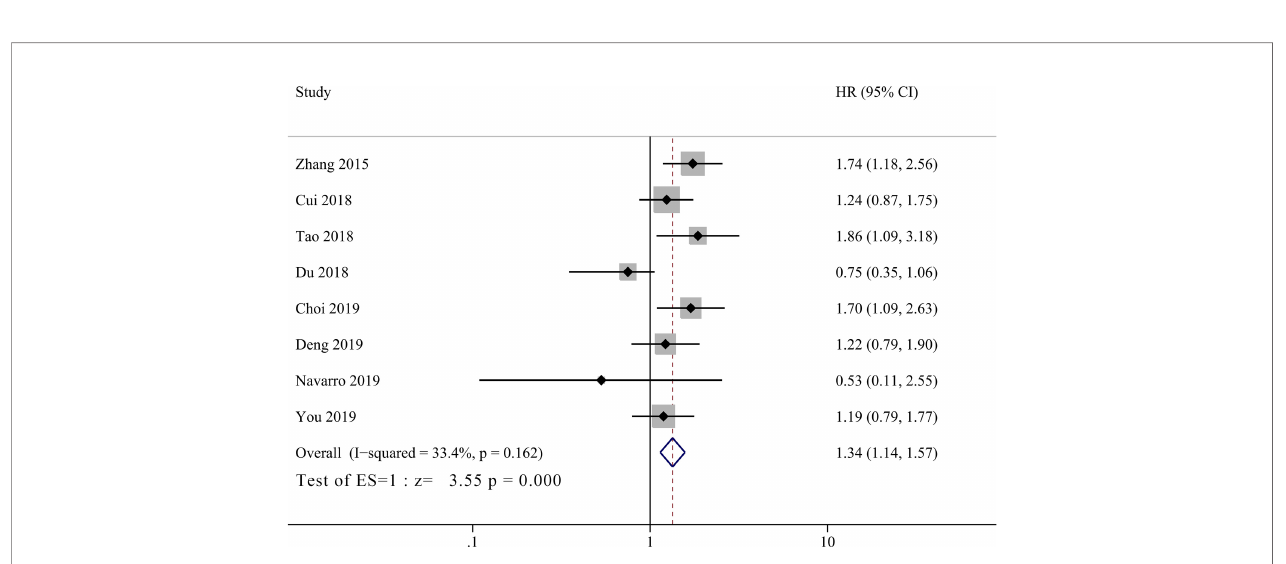
FIGURE 3 | Forest plot for the association between lymphocyte-to-monocyte ratio (LMR) or monocyte-to-lymphocyte ratio (MLR) and overall survival of patients with Gallbladder carcinoma (GBC).